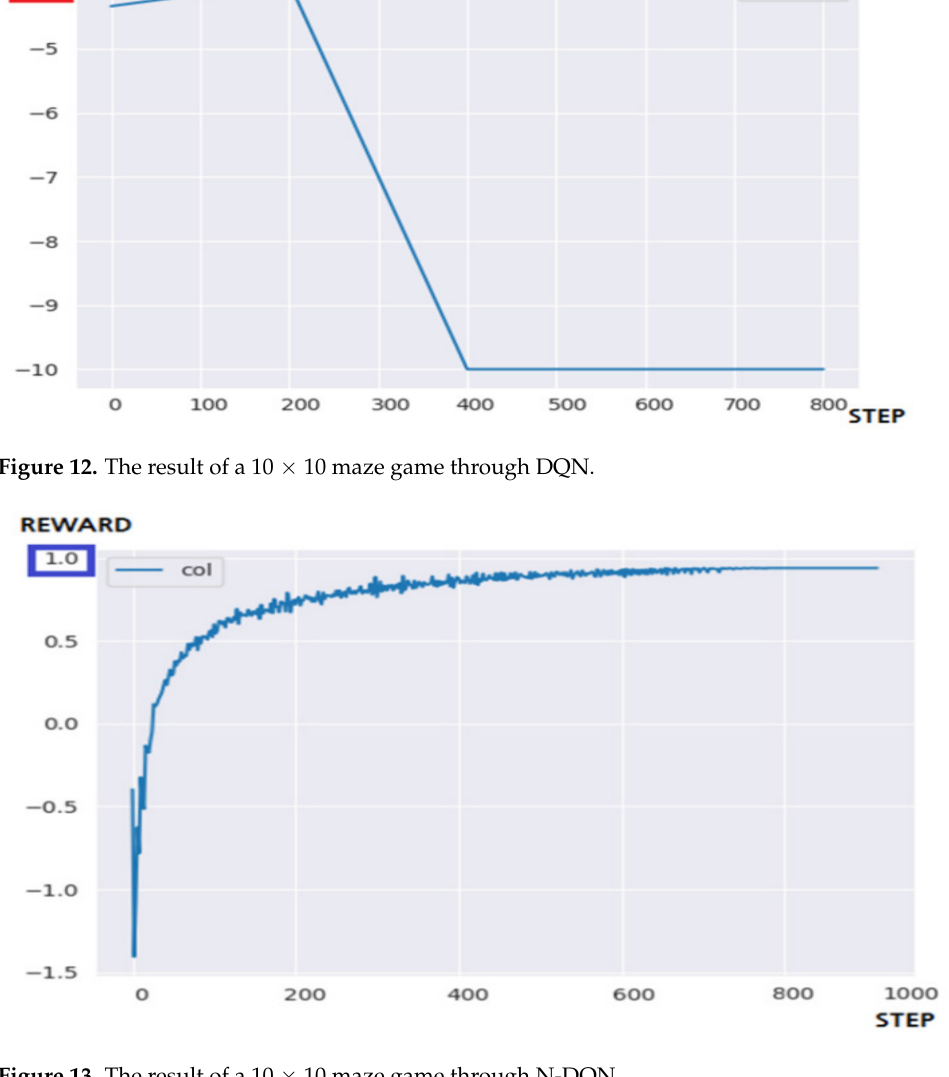
Figure 13. The result of a 10 × 10 maze game through N-DQN. Table 5. Summary of 10 × 10 learning results.